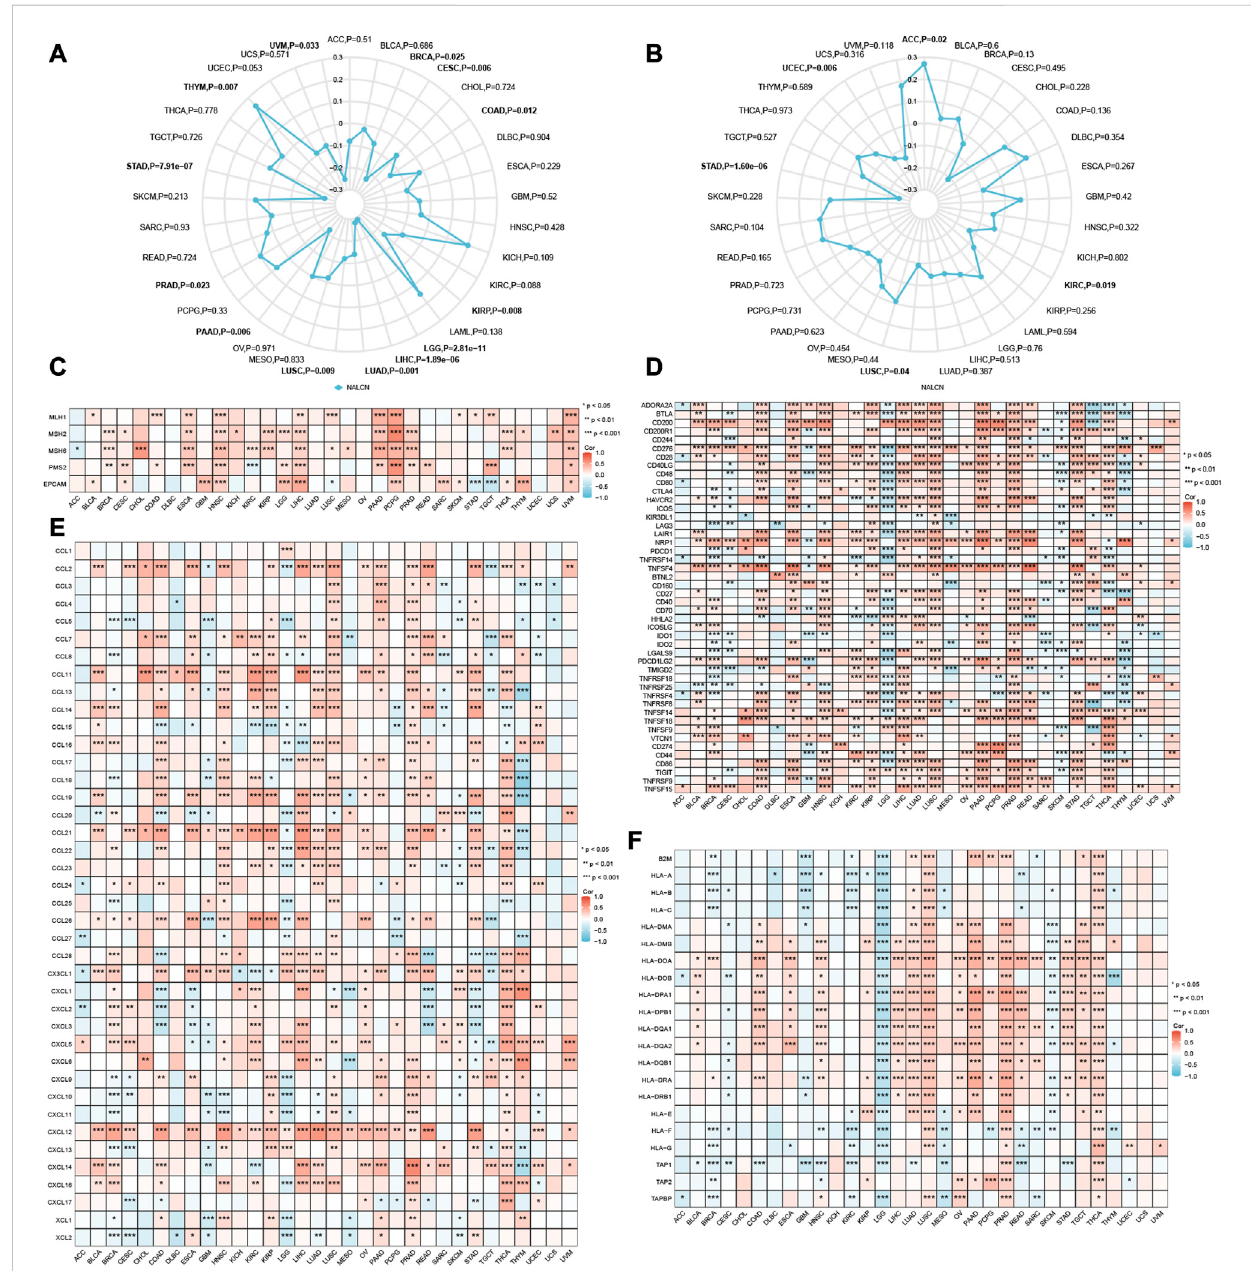
FIGURE 7 CorrelationsofNALCN expression andimmune-related biomarker. (A) Radarmap ofcorrelationbetweenNALCN expressionandTMB.The curvein blue reveals the correlation coef fi cient. (B) Radar map of correlation between NALCN expression and MSI. The curve in blue reveals the correlation coef fi cient. (C) Heatmap of correlation between NALCN expression and MMR genes. (D) Heatmap of correlation between NALCN expression and immune checkpoint genes. (E) Heatmap of correlation between NALCN expression and chemokine genes. (F) Heatmap of the correlation between NALCN expression and MHC-related genes. * p < 0.05, ** p < 0.01, *** p <